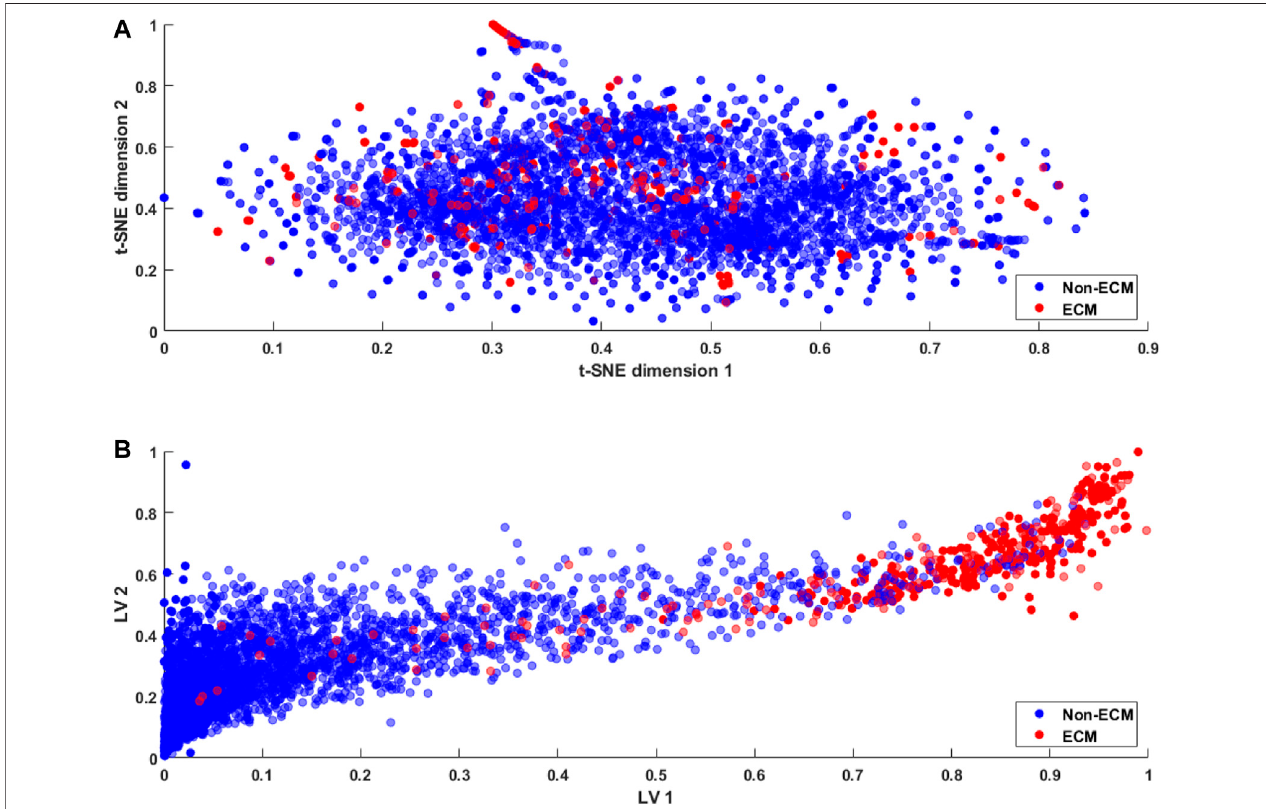
FIGURE5| Featureembedding (A) usingt-SNE(VanderMaatenandHinton,2008)projectionoftheoriginalfeaturespaceand (B) usingtheproposedlatentspace encoding (ECM-LSE) method.